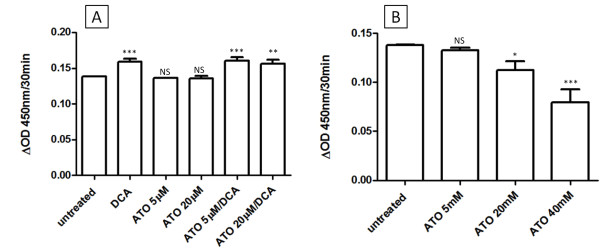
Effects of ATO and DCA on PDH activity. (A) The effects of on PDH activity in T-47D cells after 3 hr of treatment with ATO and DCA. (B) Effect of ATO treatment on the PDH activity of isolated PDH (antibody capture from T-47D cells). * P ≤ 0.05, ** P ≤ 0.001, *** P ≤ 0.0001, NS - not significant (treated vs untreated).